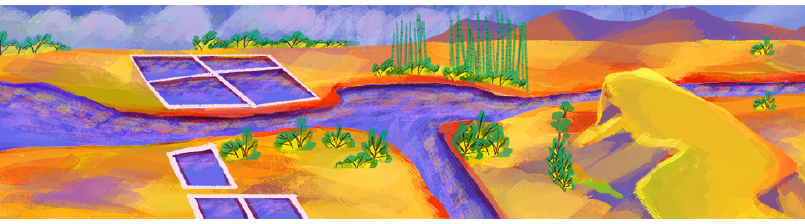
Figure 11. The Gas Village is an example of a rural locations in the interactive